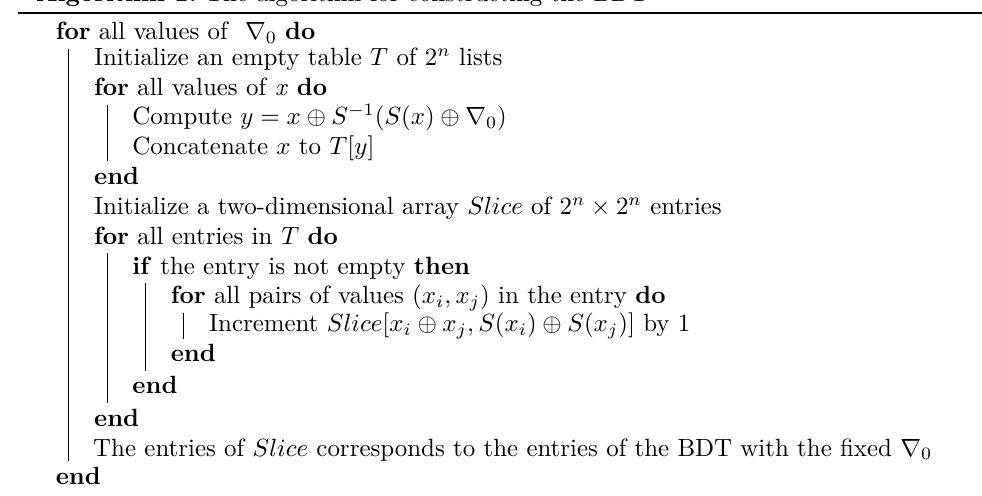
Algorithm 1: The algorithm for constructing the